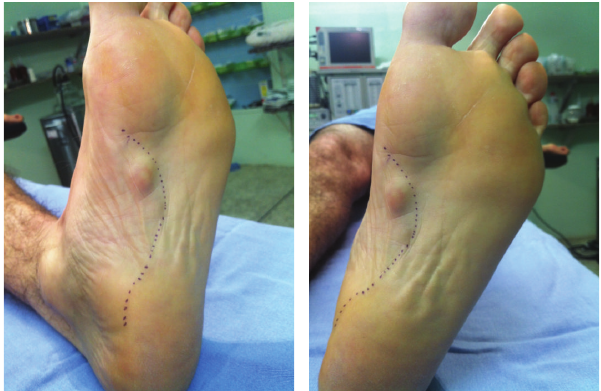
Figure 2: The planned S-curved shaped skin incision on the lateral aspect of the longitudinal plantar arch.